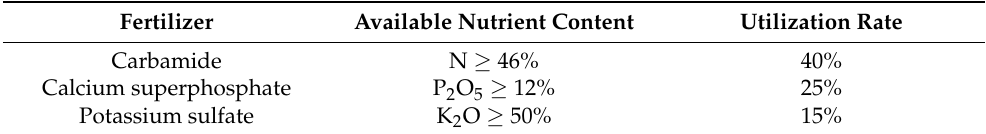
Table 1. Content and utilization of fertilizer nutrients.